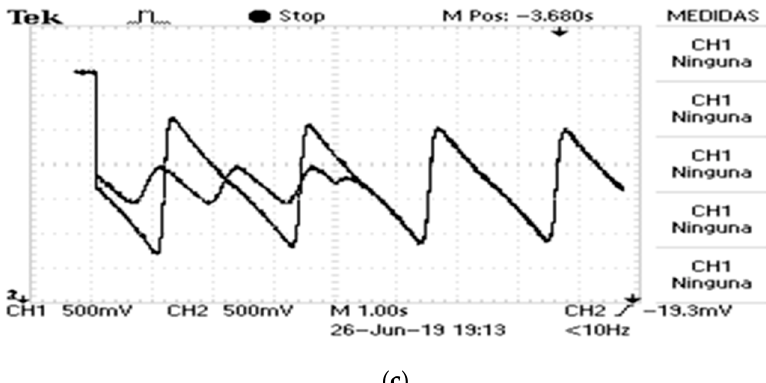
Figure 8. Synchronization process between master-slave systems by experimental result; ( a ) Synchronization process for first state; ( b ) Synchronization process for second state; ( c ) Synchronization process for third state.